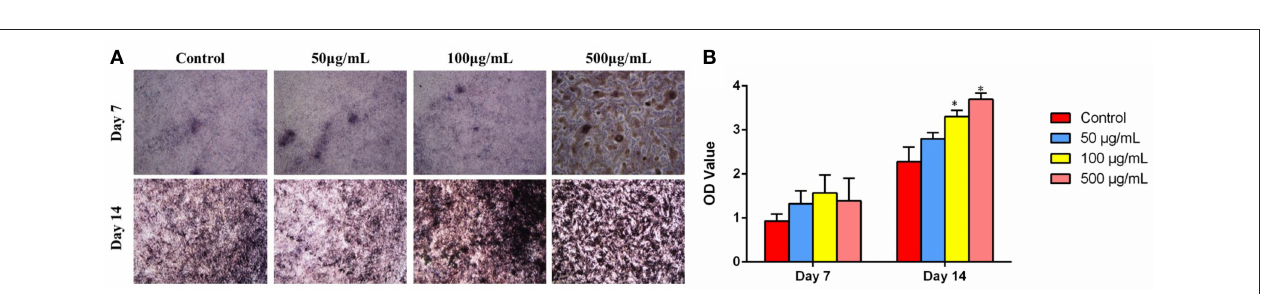
FIGURE 8 | (A) ALP staining and (B) ALP activity expression of MG-63 cells after co-culturing with HMBG nanoparticles for 7 and 14 days. *Statistically significant, p < 0.05 vs.